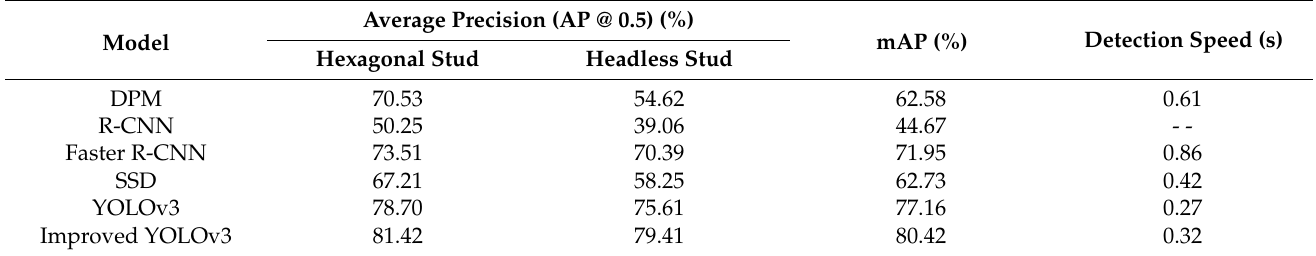
Table 5. Results of several algorithms’ detection on the studs dataset. @: IOU threshold value.